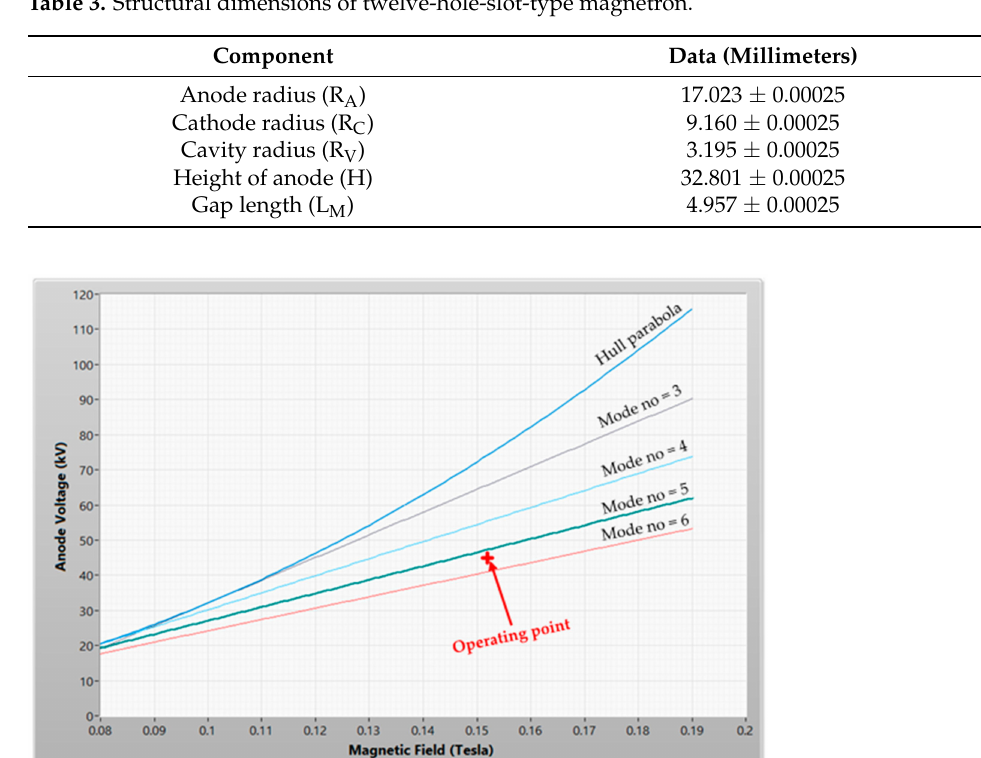
Table 3. Structural dimensions of twelve-hole-slot-type magnetron.